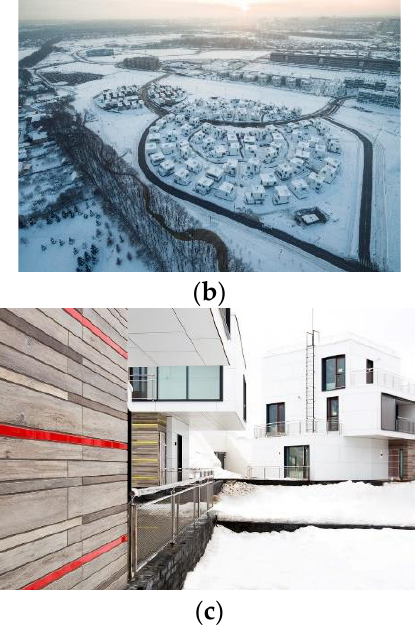
Figure 6. District 11 — Skolkovo Innovation center inspired by emperor penguin social huddling: ( a ) Master plan design; ( b ) Skolkovo village district 11; ( c ) Skolkovo’s housings details. Images ( a – c ): reprinted with permission 2019 © Agence Bechu & Associés.